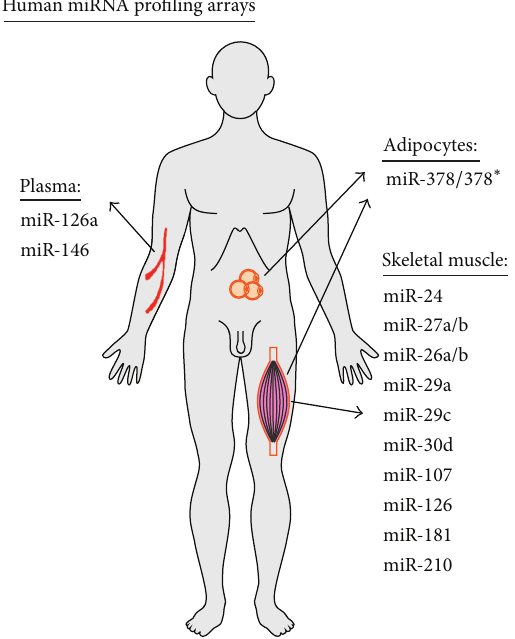
Figure 1: The most well-established miRNAs identified by human profiling arrays in diabetic